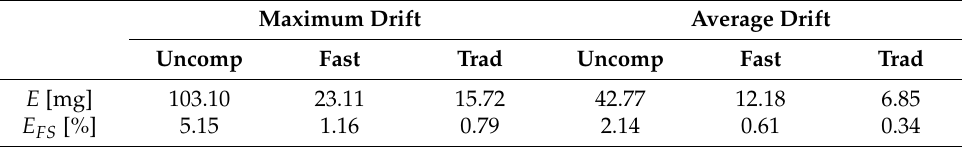
Figure 15. Average relative errors before and after compensation with both techniques. Table 7. Average and maximum deviations before and after